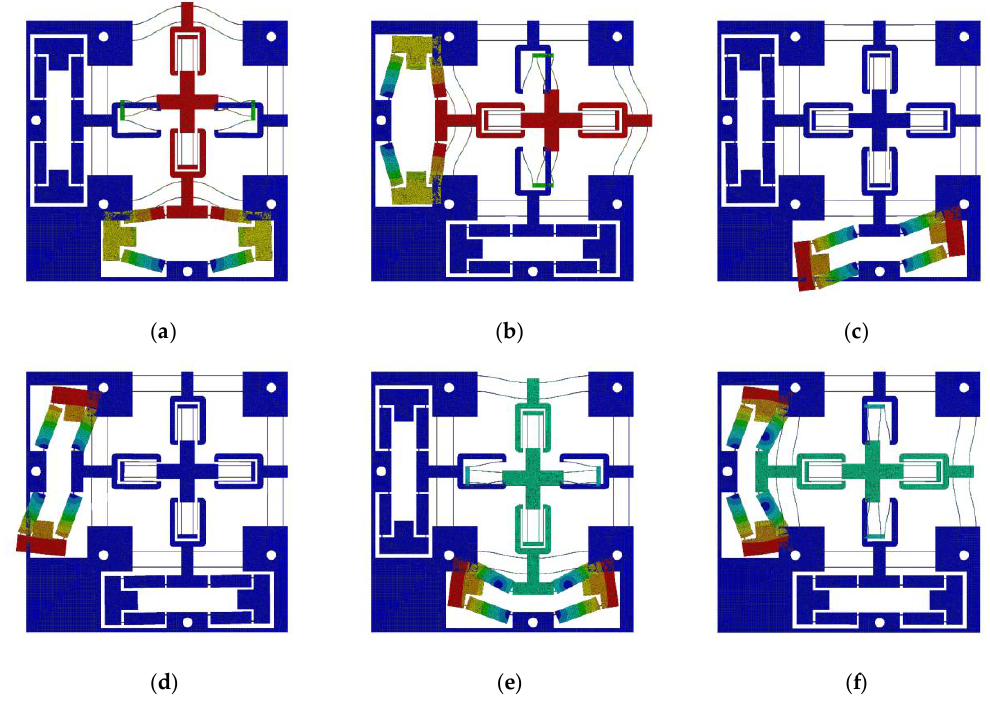
Figure 16. Modal analysis of the stage by ANSYS: ( a ) 44.234Hz, ( b ) 44.335Hz, ( c ) 88.232Hz, ( d ) 88.393Hz, ( e ) 98.418Hz, and ( f ) 98.539Hz.